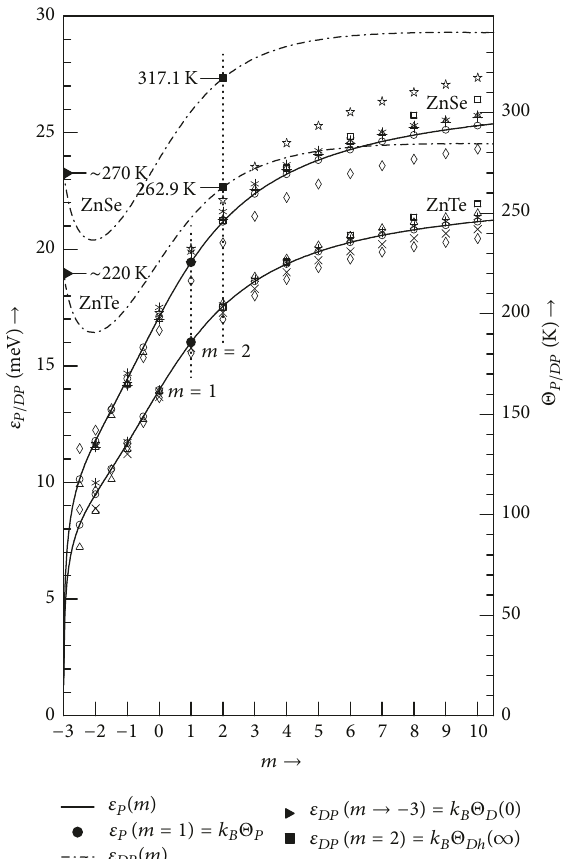
Figure 7: Visualization of the effective phonon energy curves, 𝜀 (𝑚 > −3) (see (46); solid curves), for ZnSe and ZnTe. Included 𝑃 are the corresponding discrete 𝜀 𝑃 (𝑚) points (( I ); cf. Table 5), for integer and several negative half integer orders. For comparisons with counterparts following from former theoretically calculated PDOS spectra we have shown here also the respective series of discrete 𝜀 𝑃 (𝑚) values obtained via detailed numerical analyses of thetheoreticallycalculatedPDOSspectrapresentedforZnSeand/or ZnTe in [32] ( × ), [36] ( ∗ ), [45] ( ◊ ), [46] ( △ ), [66] (+), and [89] ( f ). The series of even-order 𝜀 𝑃 (𝑚) values (for 𝑚 = 2 to 10, listed in Table 10), which have been determined in Appendix C via the conventional analyses procedure for Debye temperature values representing the harmonic lattice, Θ 𝐷ℎ (𝑇) ≅ Θ 𝐷 (𝑇) (cf. Figure 10), are represented by squares ( ◻